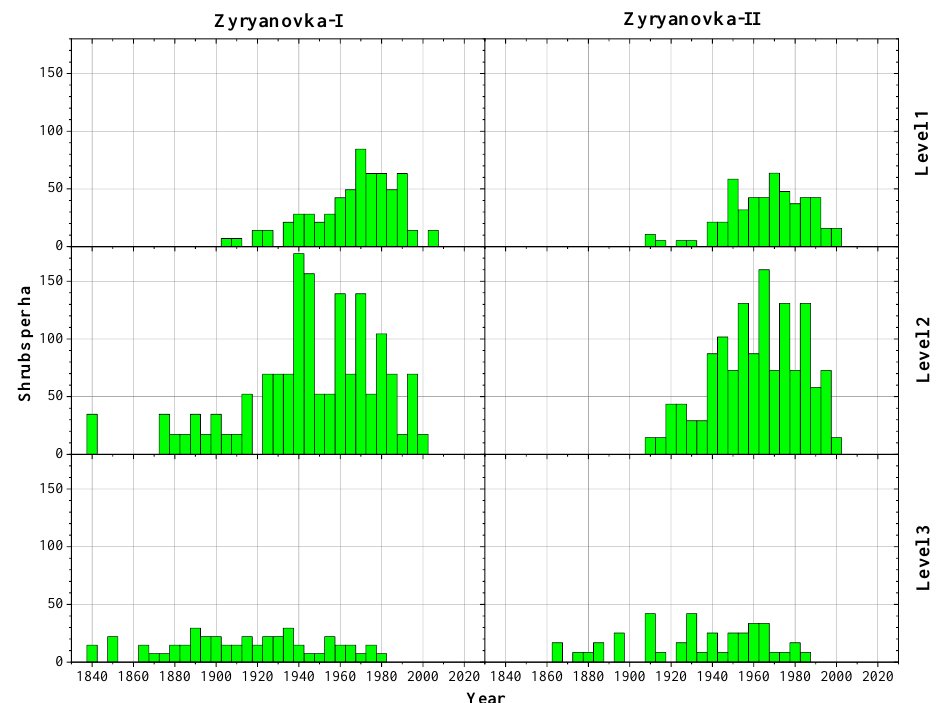
Figure 5. Age structures of J. sibirica at three altitudinal levels in Zyryanovka, Northern Urals. Levels 1, 2, and 3 correspond to the high, mid, and low elevations, respectively.